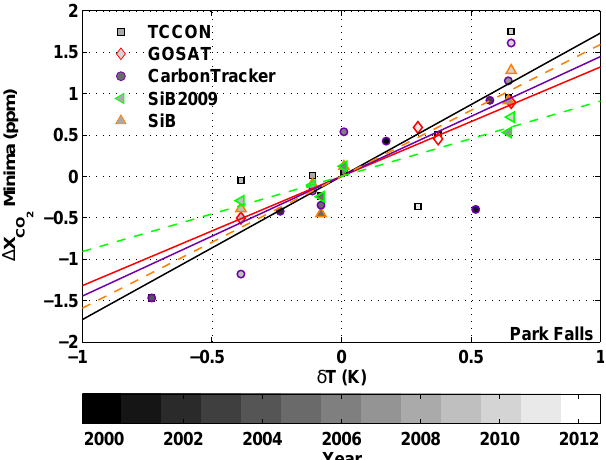
Fig. 5. The X CO seasonal cycle minima at Park Falls are plot- 2 ted against the respiration-weighted surface temperature anoma- lies from August. The TCCON data are shown in black-outlined squares, the GOSAT data in red diamonds, and the Carbon- Tracker2011 assimilation in purple circles. Each point represents a different year, with the grey shading denoting the year. The cor- respondingly colored solid lines are the best fits to the data points. The SiB model with year-specific biospheric parameters (SiB) and with a static 2009 biosphere (SiB 2009) are shown in orange and green triangles, respectively, with dashed best-fit lines. All best-fit lines are rescaled to cross zero on the y axis at zero δT .